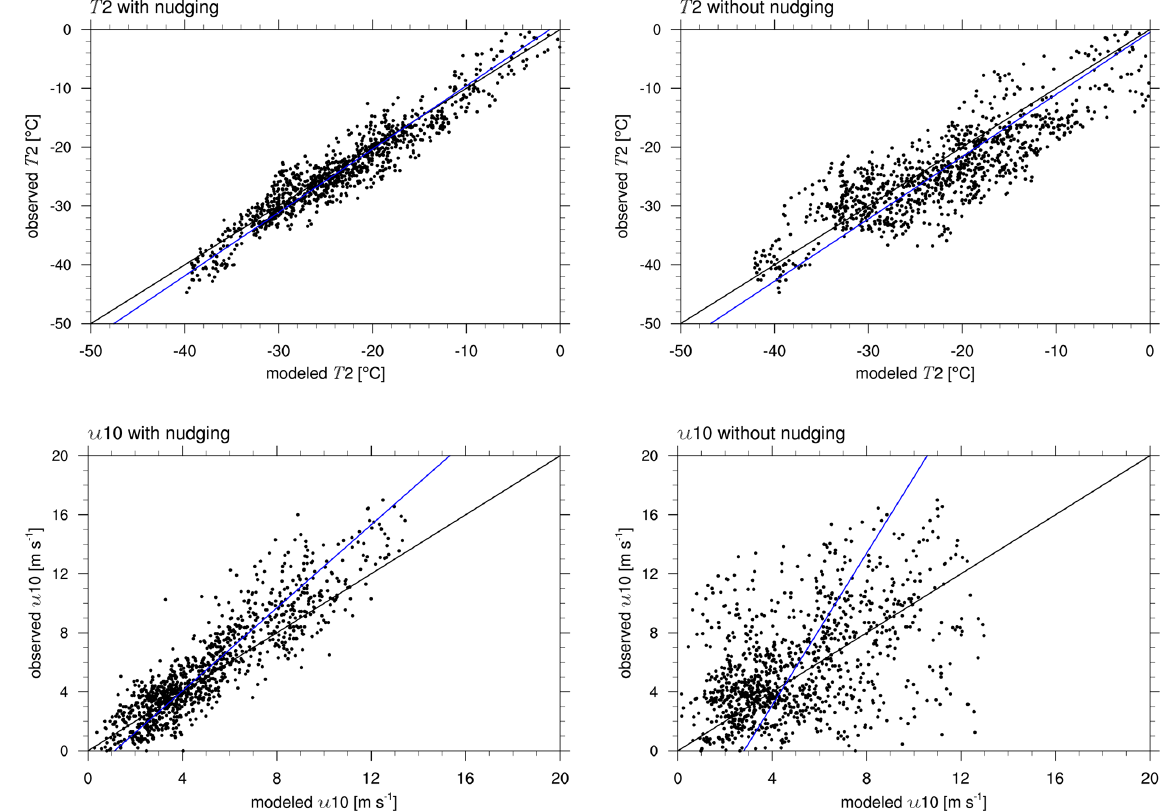
Figure 3. Correlation of observed and modeled temperature and wind speed at Utqia˙gvik for the complete time range from 1 February through 1 May 2009. The black and blue lines show perfect agreement and the regression line of the simulation and the observation,